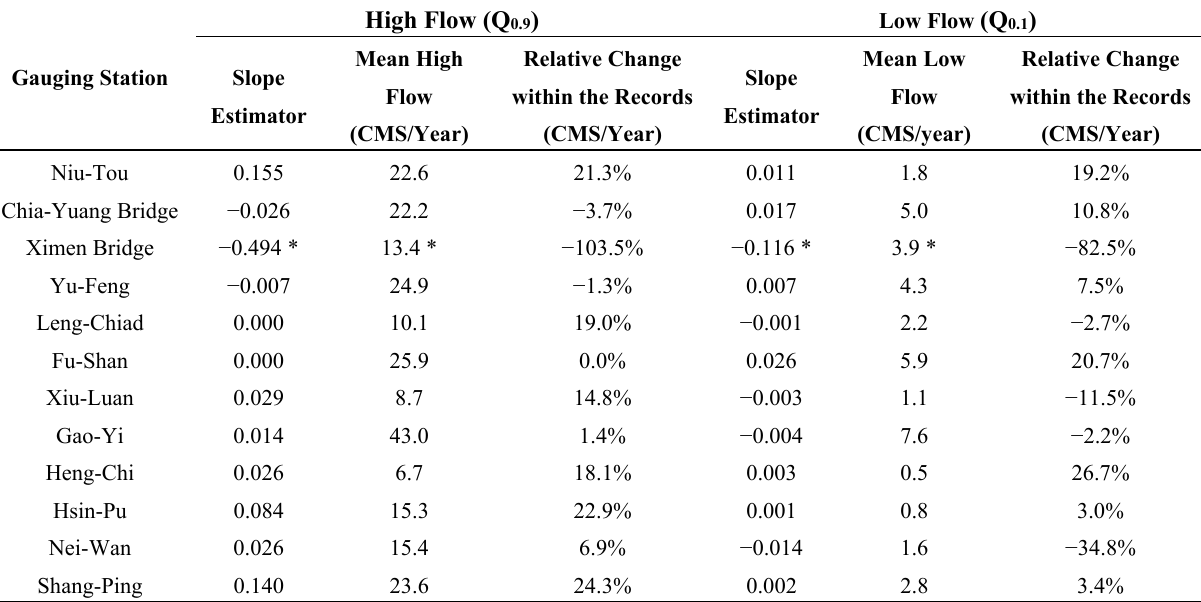
Table 8. Relative change results for the high and low flows.